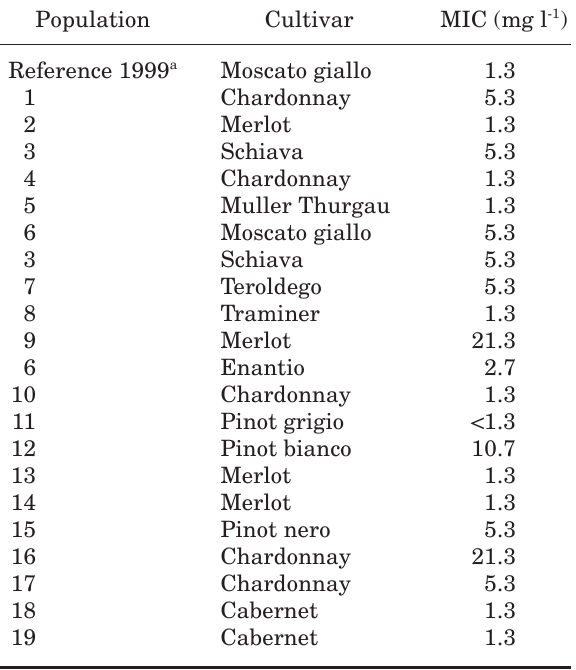
Table 1. Leaf disc test. Minimum inhibitory concentra- tion (MIC) values, expressed in mg l -1 of azoxystrobin, in 21 populations of Plasmopara viticola collected from vineyards in Trentino Alto Adige in